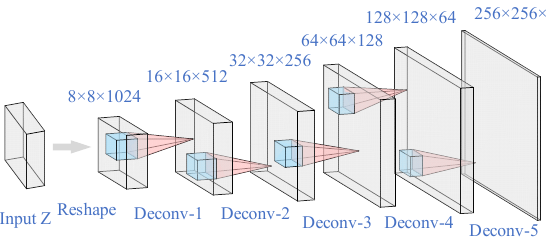
Figure 5. The architecture of the generator.